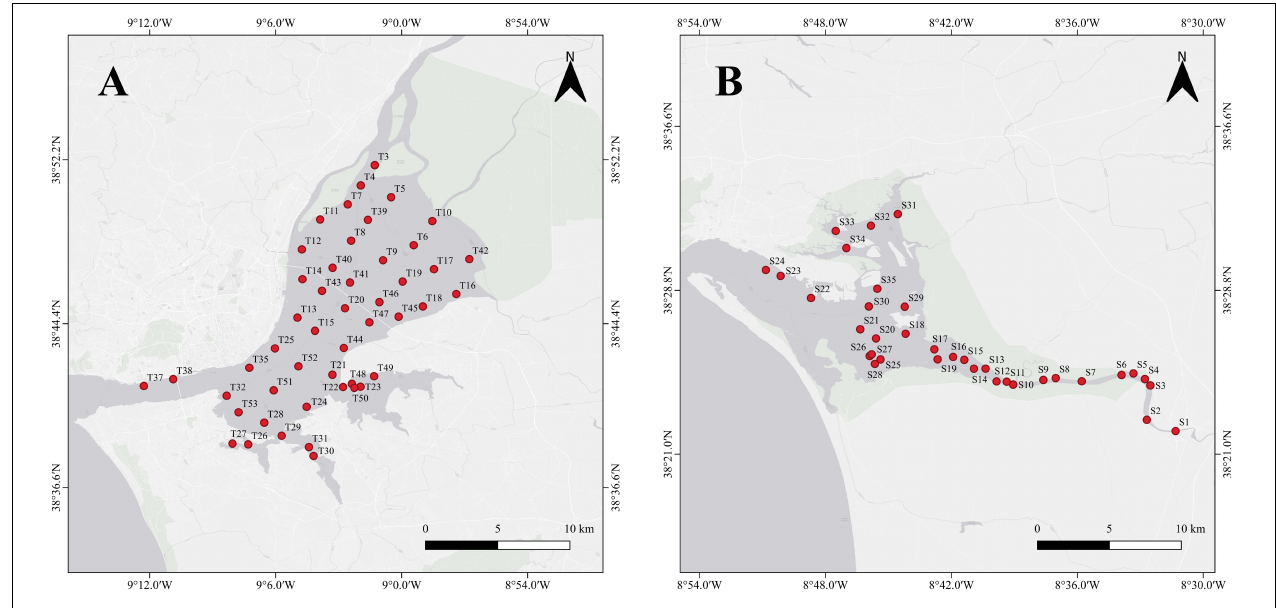
FIGURE 1 | Location of the sampling stations at Tagus (A) and Sado (B)